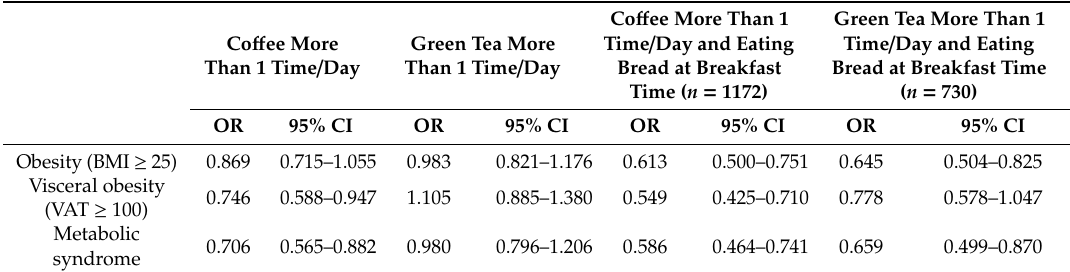
Table 4. Comparison of the association of consumption of co ff ee and green tea and bread at breakfast time with visceral obesity and metabolic